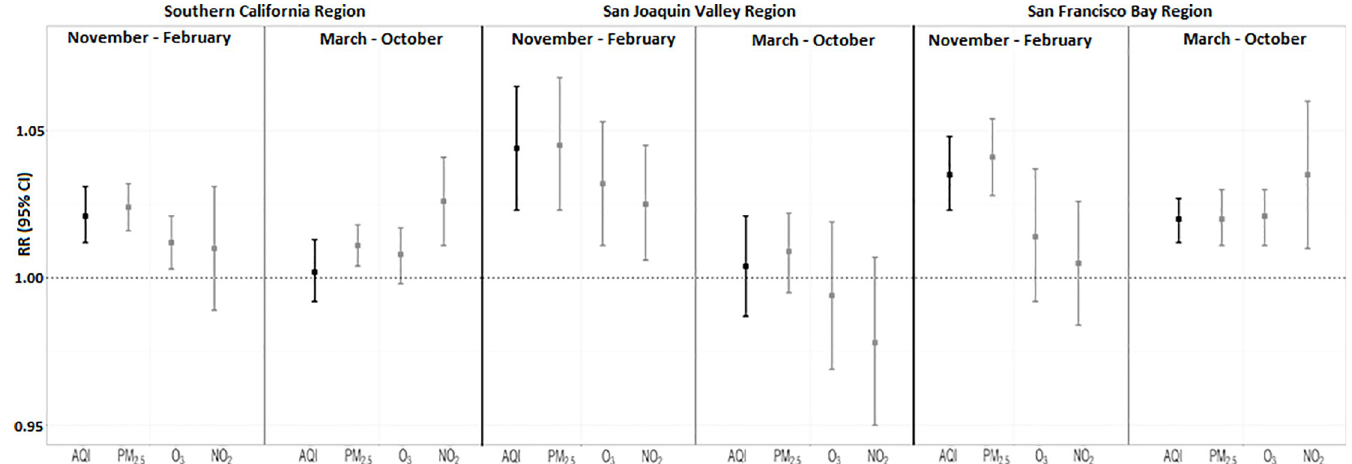
Fig 2. Relative risks of respiratory ED visits for AQI values and individual air pollutants for 2012–2014, by region. Relative risks are presented per IQR increase in AQI values and pollutant concentrations and are shown for the four-day moving average of lag days 0 through 3. Abbreviations: AQI, air quality index; CI, confidence interval; IQR, inter-quartile range; NO 2 , nitrogen dioxide; O 3 , ozone; RR, relative risk; PM 2.5 , fine particulate